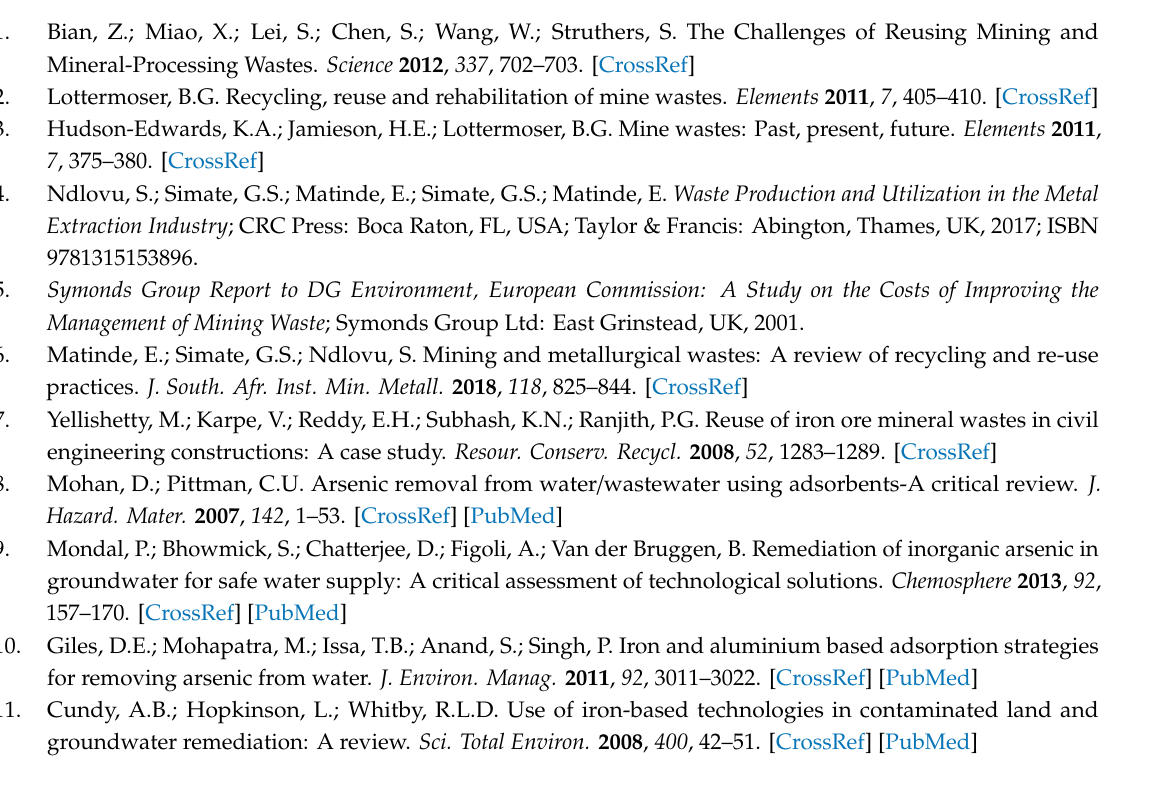
Figure S1: Geological map of Joda West Mine area, Odisha, India; Figure S2: Joda West mining site and waste stockpiles; Figure S3: Amorphous (dark bars) and crystalline (light bars) contribution to overall presence of Fe (blue), Mn (green) and Al (grey) divided into As adsorption groups: (-) “not suitable”, ( + ) “suitable) and ( ++ ) “promising”. Samples were ordered by increasing As adsorption capacity (from left to right). Semi-quantitative contribution (%) of amorphous fraction for Fe, Mn and Al is given by subtracting by XRD data (% crystalline phases) from XRF measurements (% Total element).Table S1: Part I: Mineral formula and contribution (%) of Fe, Al, Mn to each phase for the calculation of Crystalline phase used to derive semi-quantitative amorphous value. Part II: Other mineralogical phases; Table S2: (a) All samples codes, site and color description, As removal e ffi ciency (% and mg Arsenic / g material), spectral information and contribution of Crystalline and amorphous fraction of selected major elements (Fe, Al, Mn); (b) All samples codes with major (%) and minor (mg / kg) elements measured by XRF; (c) All samples codes with mineralogical phases major (PartI) and minor (PartII) (%) measured by XRD. Other phase is the sum of all minor phases. n.d. = not detectable phases; Table S3: European soil and sediments major and minor elements content (mg / kg) (FOREGS geochemical